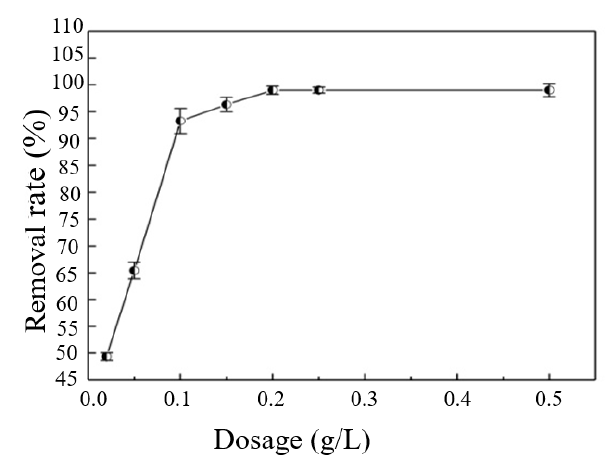
Figure 5. Optimal dosage of lanthanum modified fly ash.